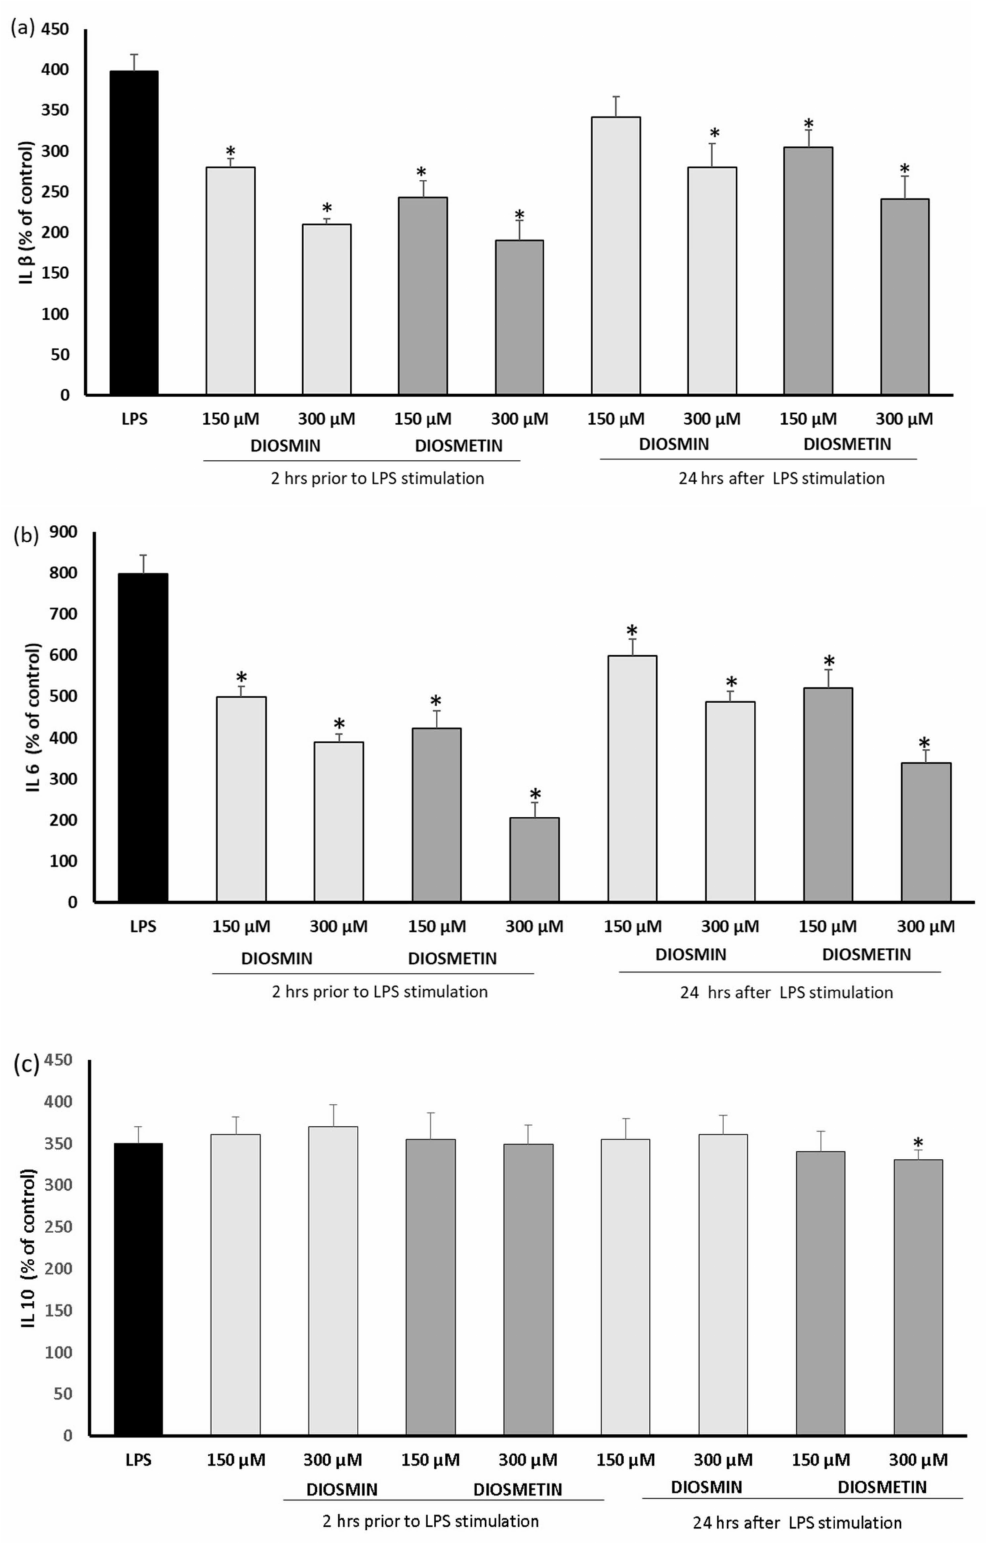
Figure 2. Effect of diosmin or diosmetin on the interleukin level: IL-1 β ( a ), IL-6 ( b ) and IL-10 ( c ) in human fibroblast cells treated with LPS. Cells were treated with diosmin or diosmetin 2 h prior to or 24 h after LPS stimulation. The data are means ± SD ( n = 3). One-way ANOVA followed by Dunnett’s multiple comparison post hoc test; the differences were considered significant at p ≤ 0.05. * indicates statistically significant